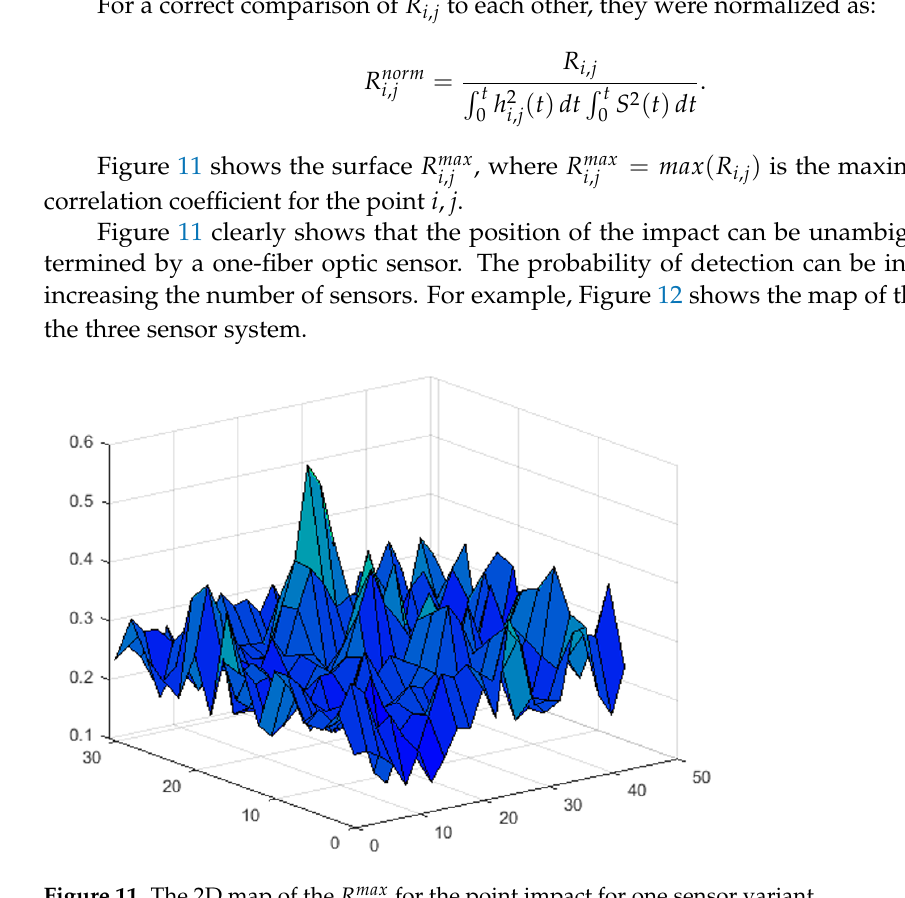
for the point impact for one sensor variant. i , j